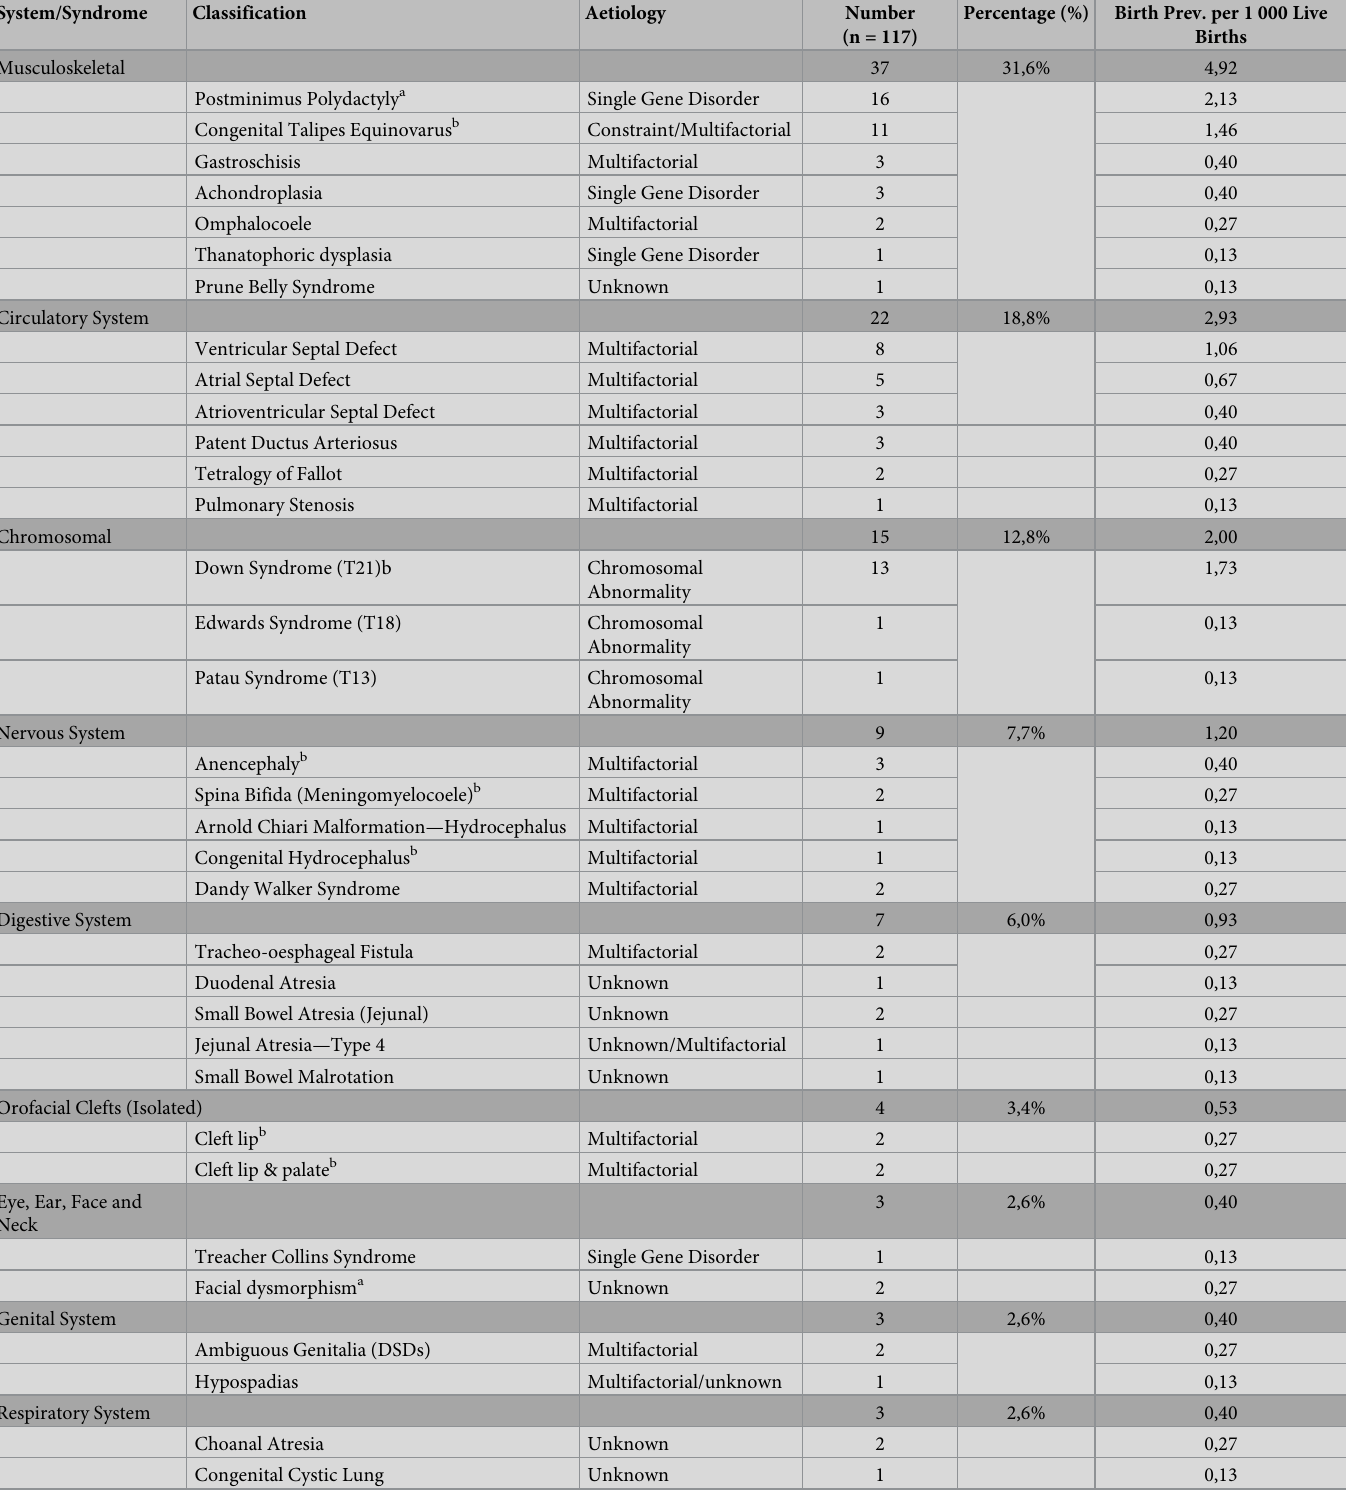
Table 2. Birth prevalence and proportion of observed congenital anomalies among live births at Edendale Hospital, SA in